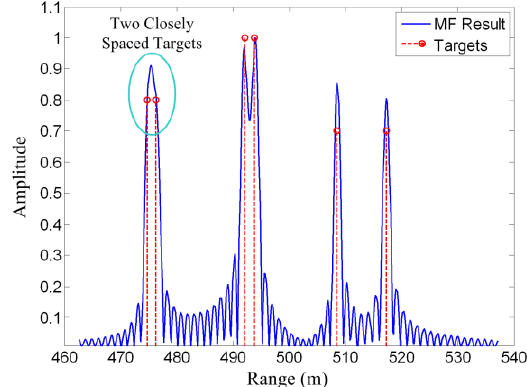
Figure 2. Matched filtering example. Two closely spaced targets cannot be resolved.